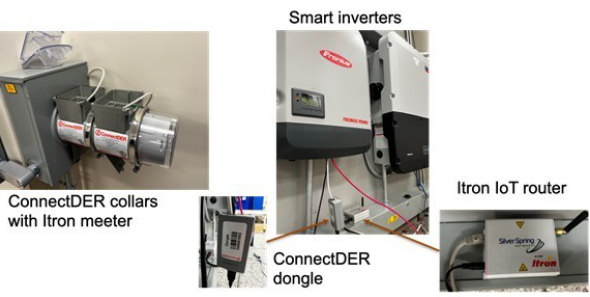
Figure 4. Physical implementation of the